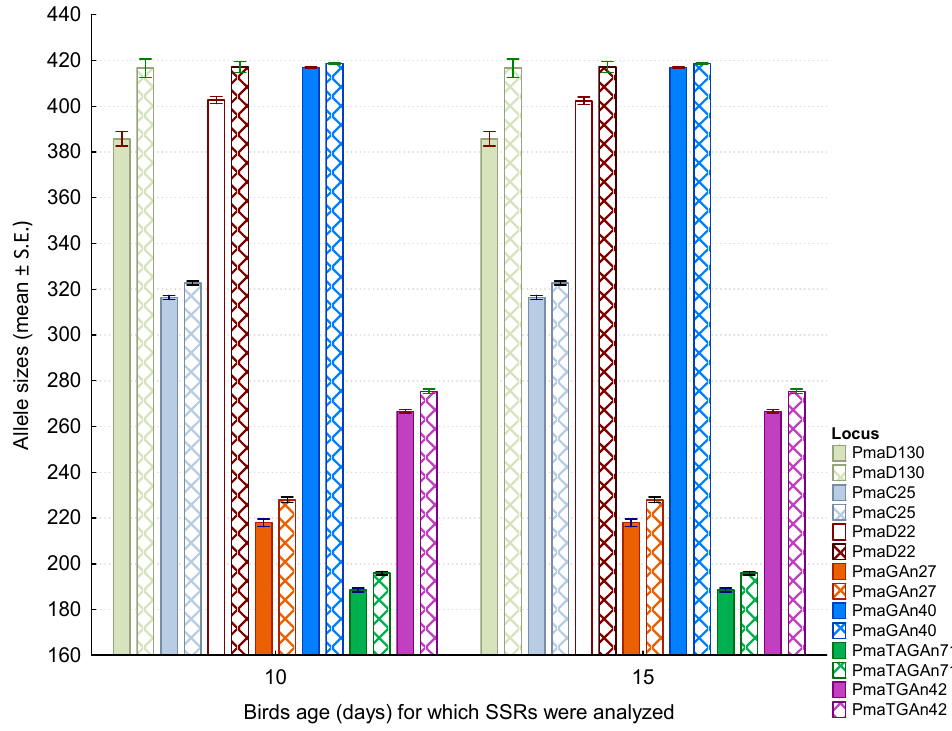
Figure 3. Allele sizes (mean ± S.E.) recorded for SSRs genotyped twice in 5-day interval for nestlings, which were supplemented with a dose of 30 µg Pb/g of body weight.